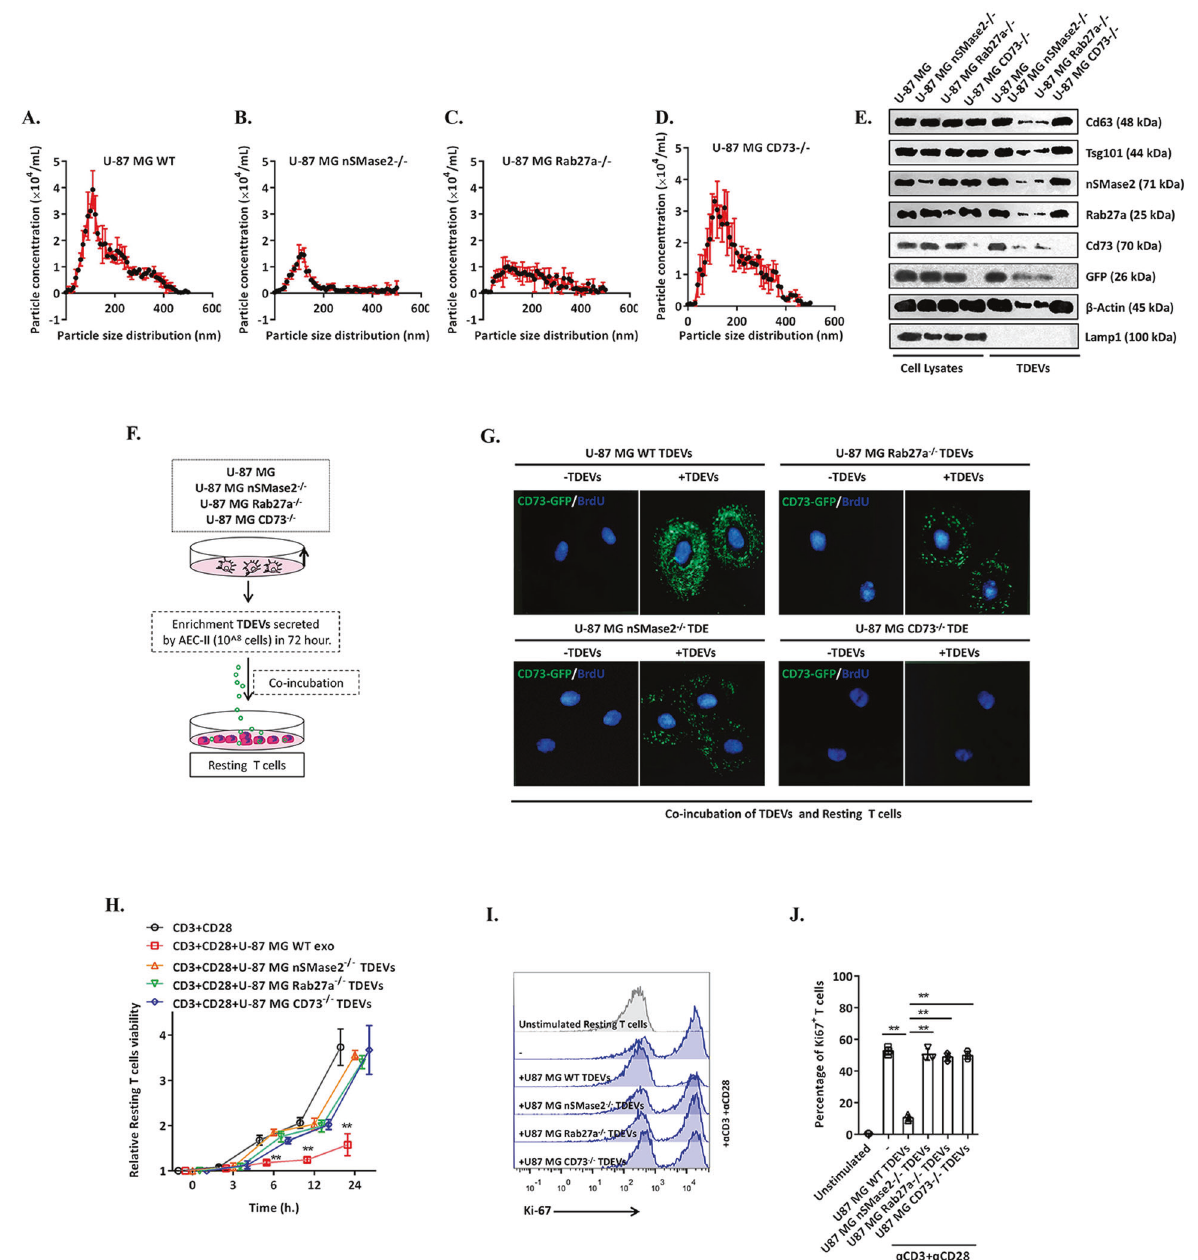
Fig. 3 CD73-positive TDEVs released by GBM inhibit T-cell clonal proliferation. A – D The count and size of TDEVs in the cell culture supernatant of WT, nSMase2 − / − , Rab27a − / − and CD73 − / − U-87 MG cells were detected by nanoparticle tracking analysis. E Representative immunoblot of the expression of CD63, TSG101, lamp1, nSMase2, Rab27a and CD73 in cell lysates and TDEVs of WT, nSMase2 − / − , Rab27a − / − and CD73 − / − U-87 MG cells. F Schematic diagram of the cocultivation experiment involving WT, nSMase2 − / − , Rab27a − / − and CD73 − / − U-87 MG GBM cells and T cells. G Representative confocal microscopy images of GFP-labelled nanovesicles in T cells cocultured with HAs and U-118 MG, U-87 MG and U-251 MG cells before and after 12 h. H WT, nSMase2 − / − , Rab27a − / − and CD73 − / − U-87 MG GBM cell viability was detected by CCK-8 assays in the presence of α CD3 + α CD28. H Representative fl ow cytometry diagram of Ki-67 expression in WT, nSMase2 − / − , Rab27a − / − and CD73 − / − U-87 MG GBM cells in the presence of α CD3 + α CD28. I Graph of the percentage of KI-67-positive T cells, related to ( H ). Data are shown as the mean ± SD; t test, * p < 0.05 and ** p < 0.01 compared to unstimulated T cells. All data are from three independent repeated experiments ( H – J external or internal. In fact, as early as 2011, studies found that and metastatic brain cancer patients. High CD73 expression levels CD73 + TDEVs secreted by a variety of cancer cells inhibit the can be detected on the surface of CD45 + immune cells, especially immune activity of T cells in vitro [5]; in addition, high levels of CD4 + and CD8 + T-lymphocytes (fold change compared to tumour- CD73 expression can be detected in GBM and are related to the resident macrophages (TRMs), DCs, and neutrophiles: 46, 26 and 567 poor prognosis of GBM [4, 23, 24]. Our research showed that these and 15, 8.4 and 181, respectively). However, it remains unknown CD73 + TDEVs enriched in exosomes originate from GBM cells and whether the origin of CD73 on the surface of these T-lymphocytes is